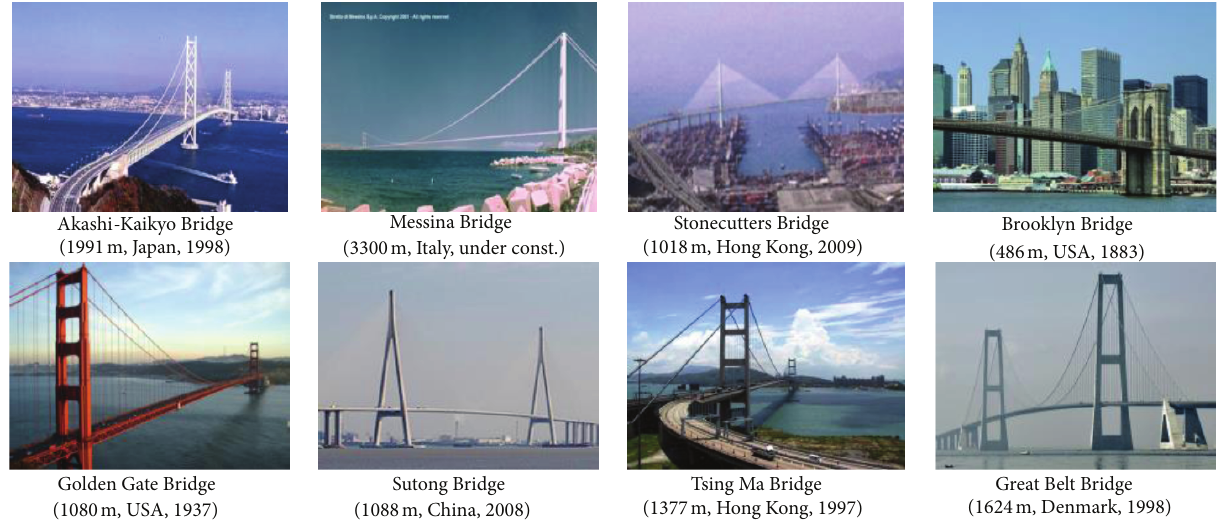
Figure 1: World-landmark cable bridges. The parenthesis shows the main span length, country, and constructed year.